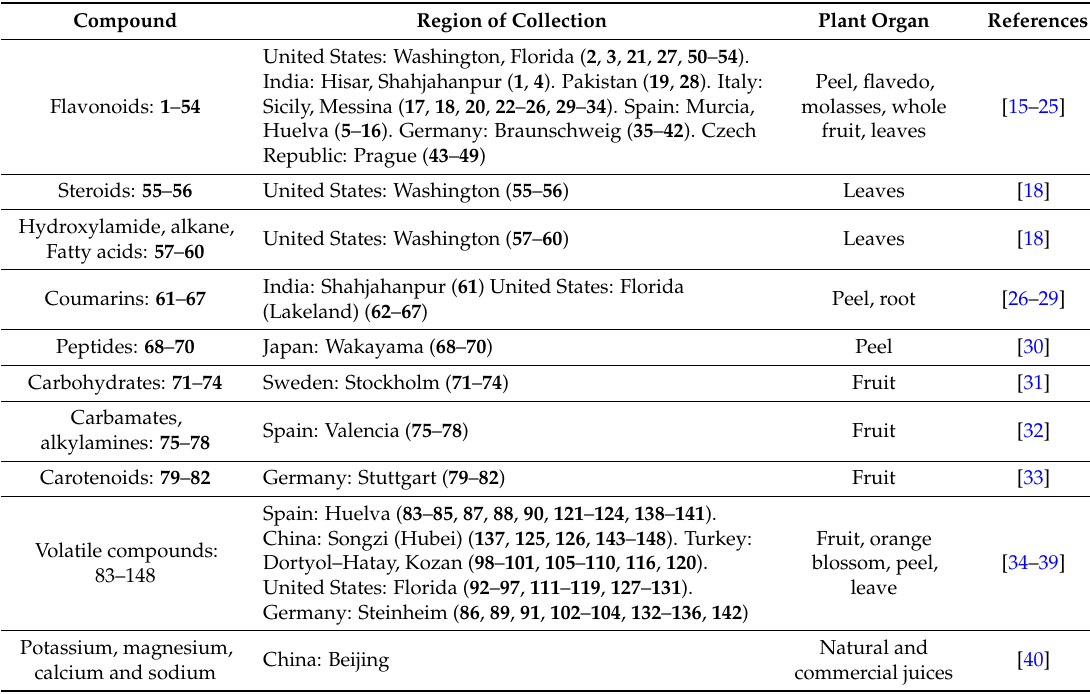
Table 1. Groups of compounds, region of collection and plant